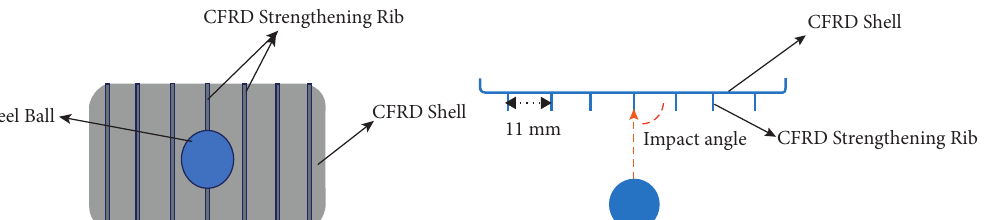
Figure 4: Ball impact position and direction.